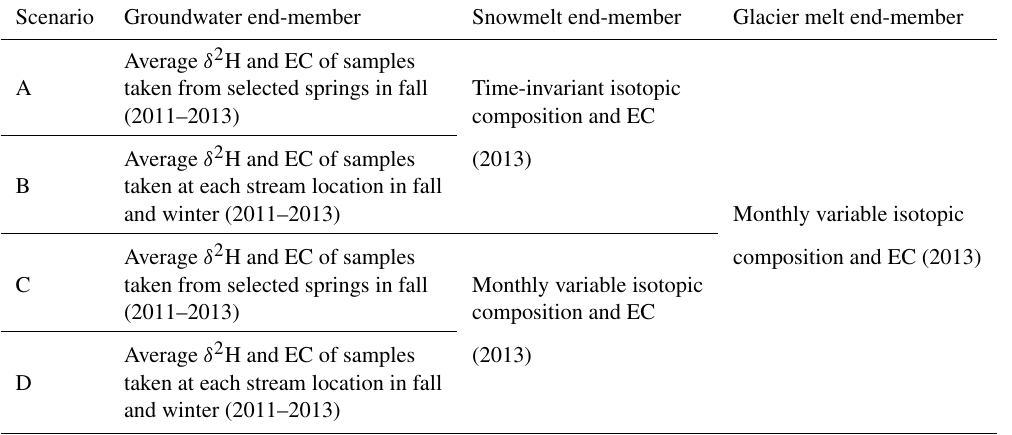
Table 2. Summary of the properties of the end-members used in the four mixing model scenarios for 2013 data.